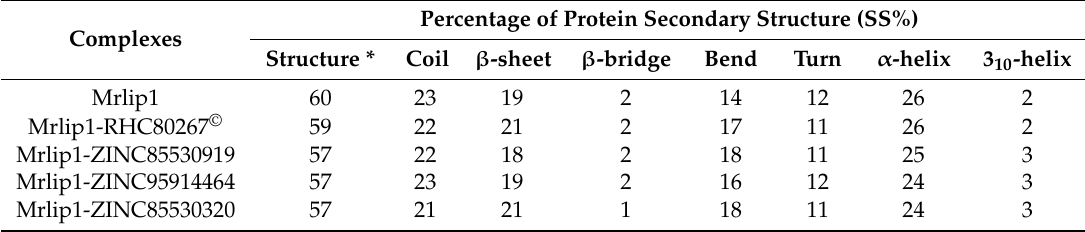
Table 5. Percentage of residues that participated in average structure